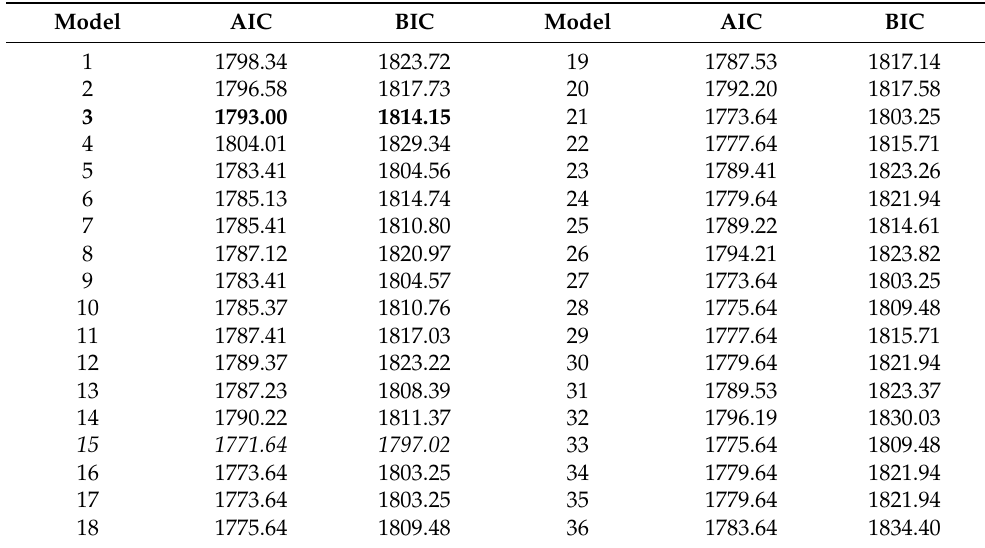
Table 7. AIC (Akaike information criterion) score and BIC (Bayesian Information Criterion) score of 36 models derived from the base